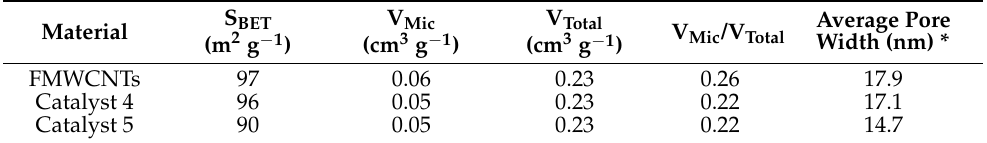
Table 1. Textural properties of the materials.